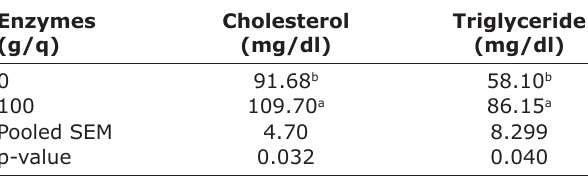
Table 6: Effect of feeding different levels of enzymes on the lipid profile of blood in broiler. Enzymes (g/q)